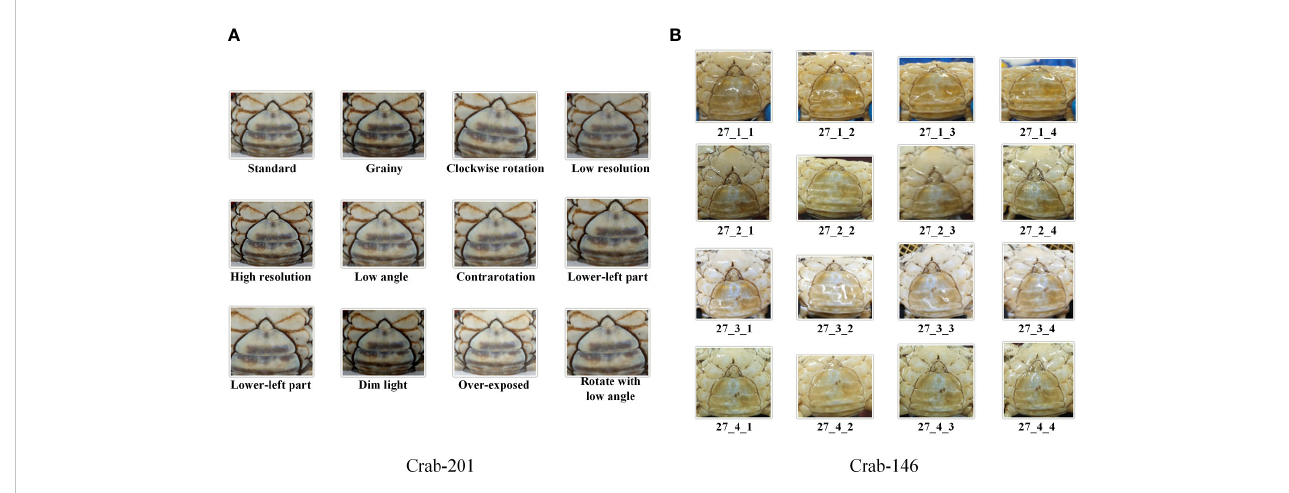
FIGURE 3 Demo images of the two crab abdomen datasets. (A) Crab-201. (B) Crab-146.